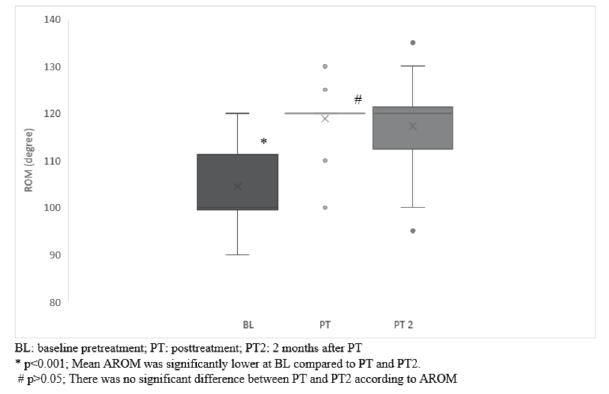
Figure 4 - Change in mean WOMAC-OI total scores and sub parameters at BL, PT, and PT2 periods.